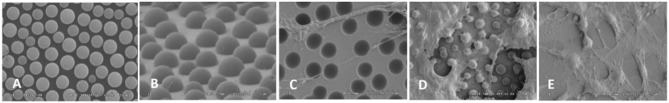
(A) PS surface with micrometer scale pits, × 10,000; (B) PLLA surface with micrometer scale islands, × 10,000; OCT-1 osteoblasts on (C) PS surface with micrometer scale pits (× 5,000), (D) PLLA surface with micrometer-scale islands (× 2,500), and (E) smooth PLLA surface (× 1,200) (Wan et al., 2005) [Readapted with permission from Wan et al. (2005). Copyright 2004 Elsevier Ltd.].